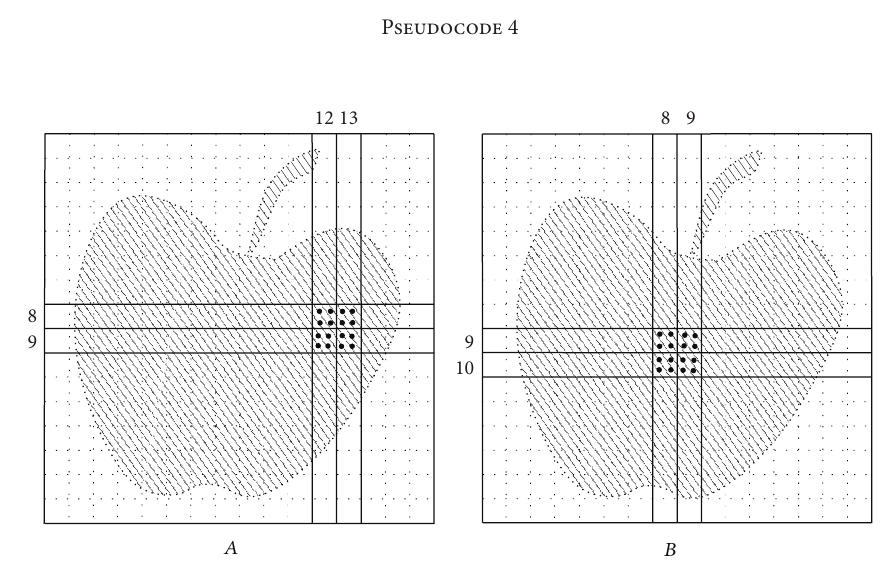
Figure 1: Two figures with high similarity.